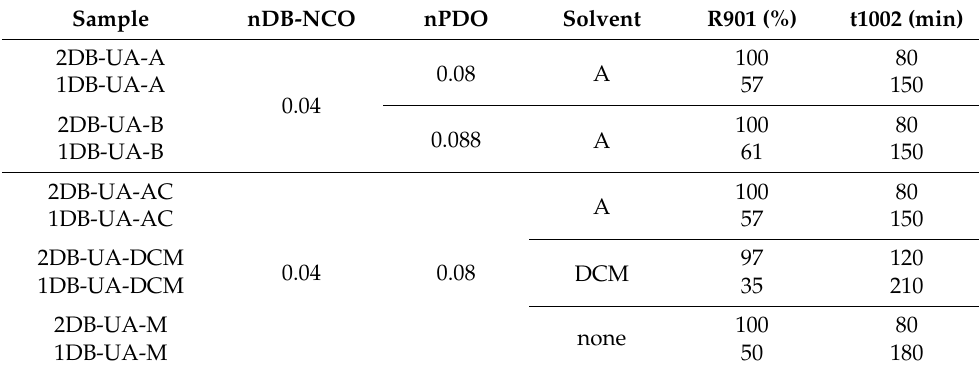
Table 2. Conditions and results for resin